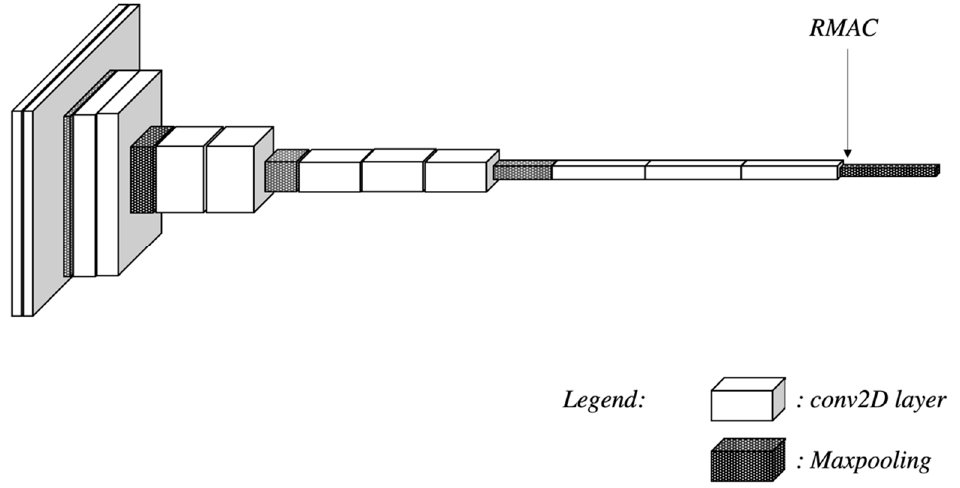
Figure 8. Position of the RMAC layer in VGG16.